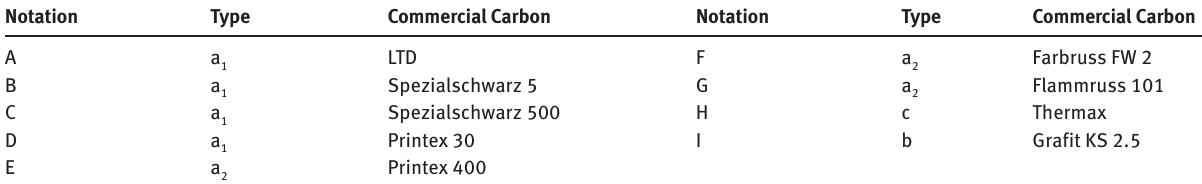
Table 1: Types of different carbon types